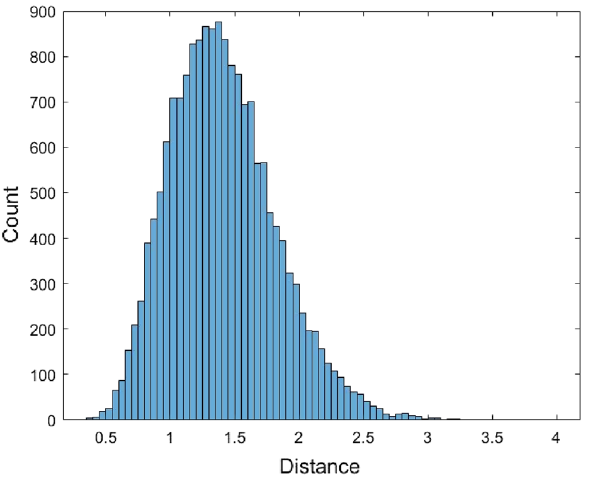
Figure 8. The histogram of 17,519 data generated from the fitted Gamma distribution of the Kimura model distance data.